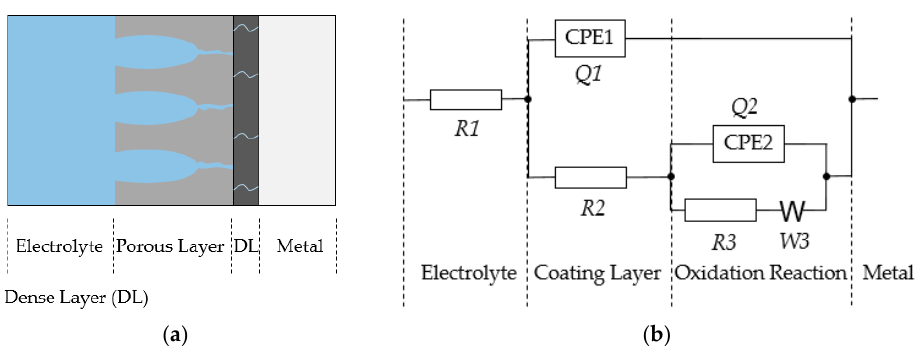
Figure 6. Schematic illustration ( a ) and equivalent circuit ( b ) representation with mixed kinetic and charge-transfer control used to model the electrochemical impedance spectroscopy (EIS) spectra of PEO-coated specimens.